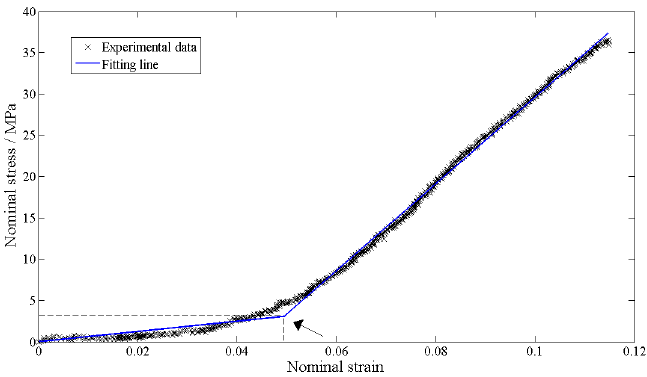
Figure 3. Example bilinear curvefitting of stress-strain tensile experimental data. The arrow indicates the transition point of the fitting line from the toe-region to the linear region.